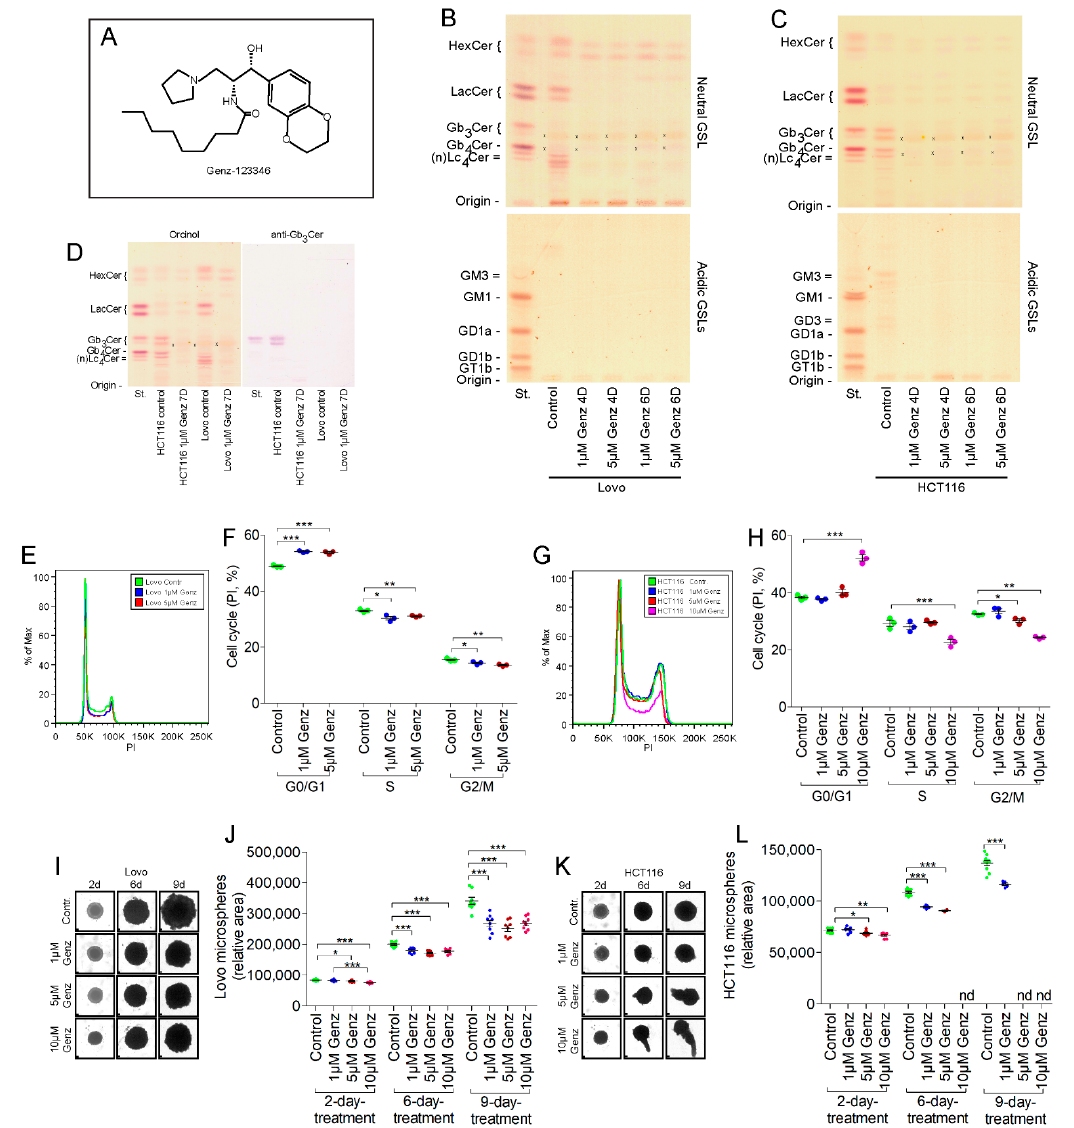
Figure 2. Treatment of Lovo and HCT116 cells with Genz lead to reduced GSL expression and cell cycle arrest. ( A ) Formula of the GCS inhibitor Genz-123346 ( N -[(1 R ,2 R )-1-(2,3-dihydro-1,4-benzodioxin-6-yl)-1-hydroxy-3-pyrrolidin-1-ylpropan-2- yl]nonanamide). ( B , C ) As shown by thin layer chromatography (TLC), GSL-synthesis was almost completely disrupted by treatment of Lovo ( B ) and HCT116 cells ( C ) with 1 µ M Genz in the culture medium after 4 and 6 days; x, no GSL-positive band; running solvent for neutral GSLs was CHCl 3 /CH 3 OH, H 2 O, 62.5:30:6 ( v / v ) and for acidic GSLs CHCl 3 /CH 3 OH, 0.2% CaCl 2 , 60:35:8 ( v / v ). ( D ) Anti-Gb 3 Cer immune overlay of the neutral GSL-fraction from Lovo and HCT116 cells. Chemical staining with orcinol reagent (left) and immune overlay with anti-Gb 3 Cer antibodies. HCT116 cells expressed globosides in addition to hexosylceramides and lactosylceramides, which were not detectable in Lovo cells. ( E , F , quantification) Cell cycle arrest of the Lovo cells in S and G2/M phases occurred after treatment with 1 µ M Genz ( G , H , quantification). A significant influence on the cell cycle of HCT116 cells as shown by FACS analysis occurred at 5 µ M Genz and higher concentrations. ( I – L ) One micrometer of Genz inhibited growth of tumor spheroids from Lovo ( I , J , quantification) and HCT116 cells ( K , L , quantification). Note: HCT116 microspheres broke apart with elevated Genz concentrations after longer incubation period ( K ) and could therefore not be included in the calculations ( L , nd, not done); each data point on the graphs represents one biological replicate; scale bars, 100 µ M; significances are *, p ≤ 0.05; **, p < 0.01; ***, p <